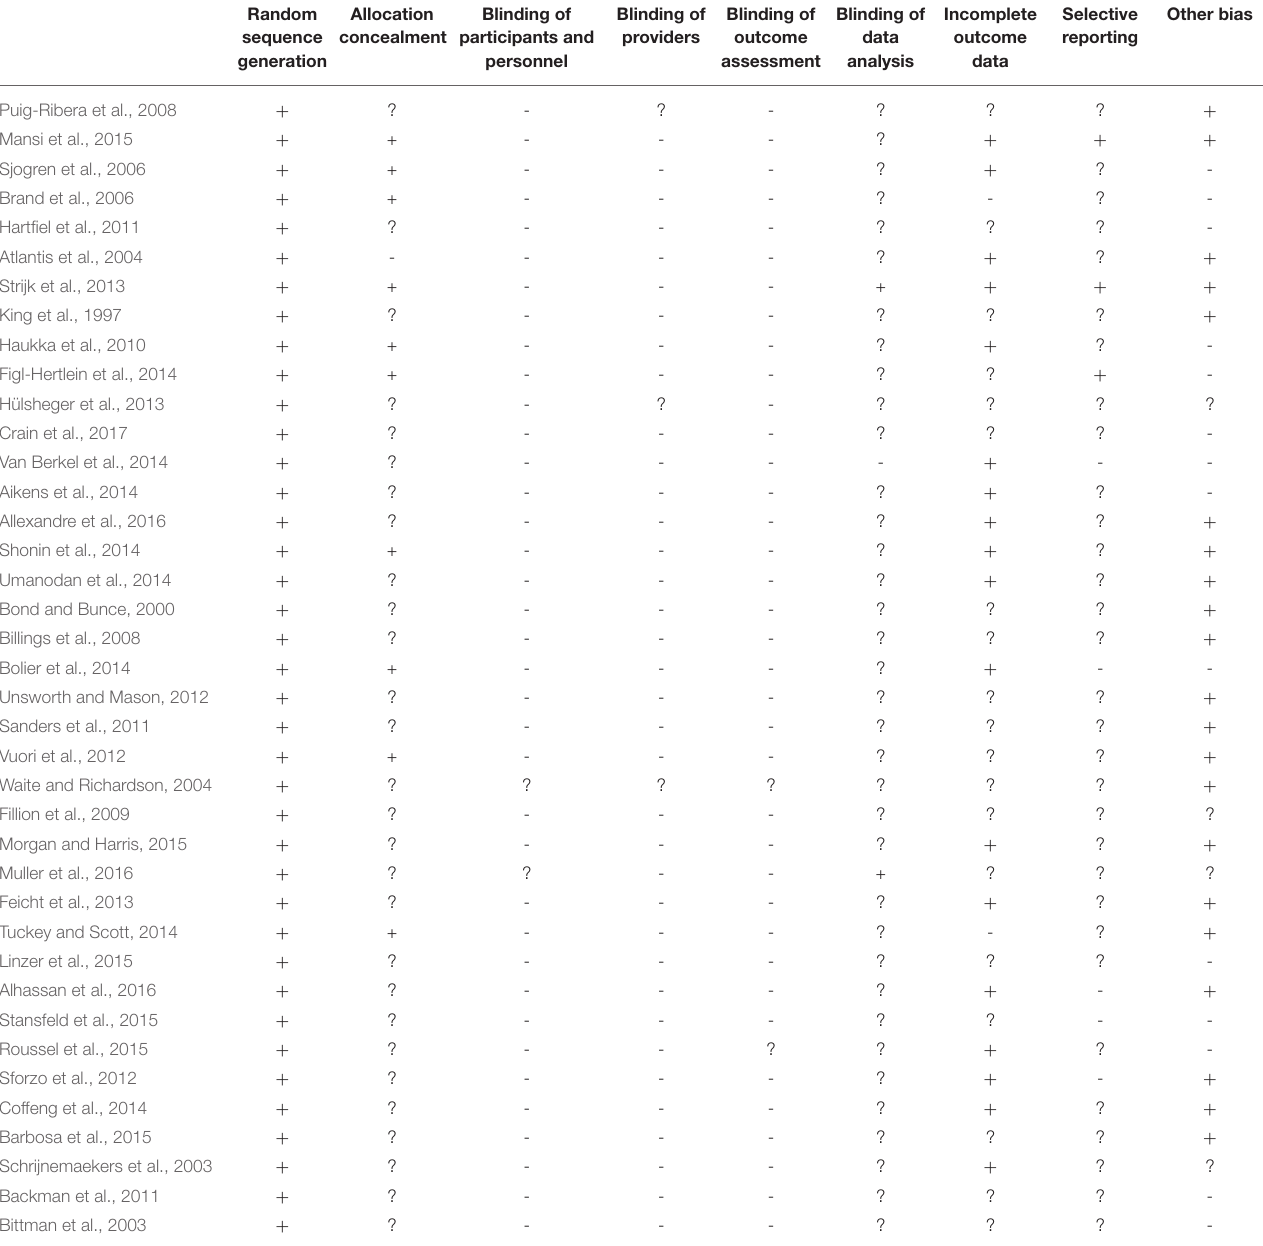
TABLE 2 | Analysis by grading of recommendation assessment, development, and evaluation (GRADE) risk of bias